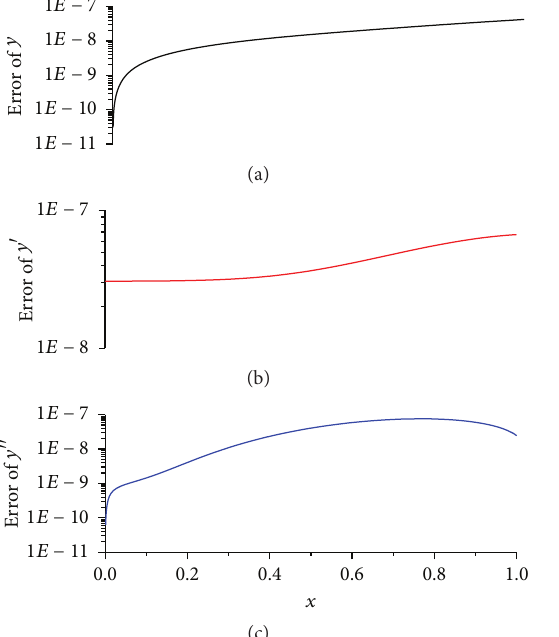
Figure 5: Example 3 showing the errors of the first numerical solution by comparing with the exact